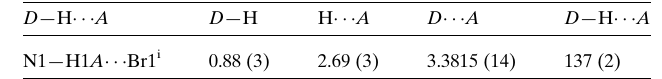
Table 2 Experimental details. Crystal data Chemical formula